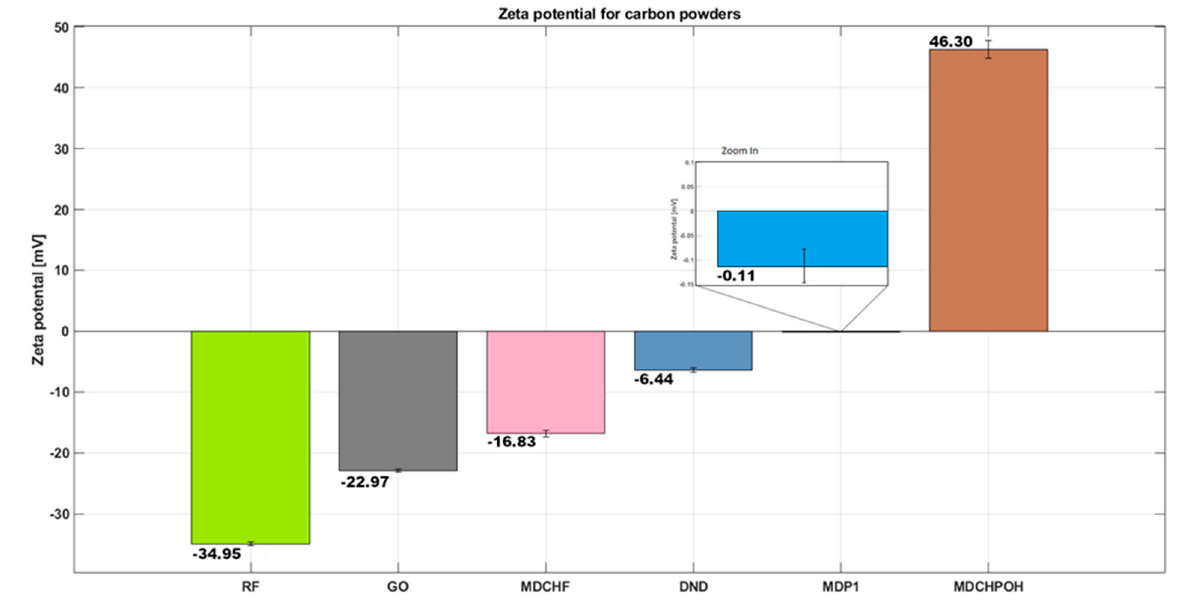
Figure 10. A comparison of tested carbon powders in relation to zeta potential. Also noteworthy is electrokinetic potential near “0” value, − 0.11 mV for